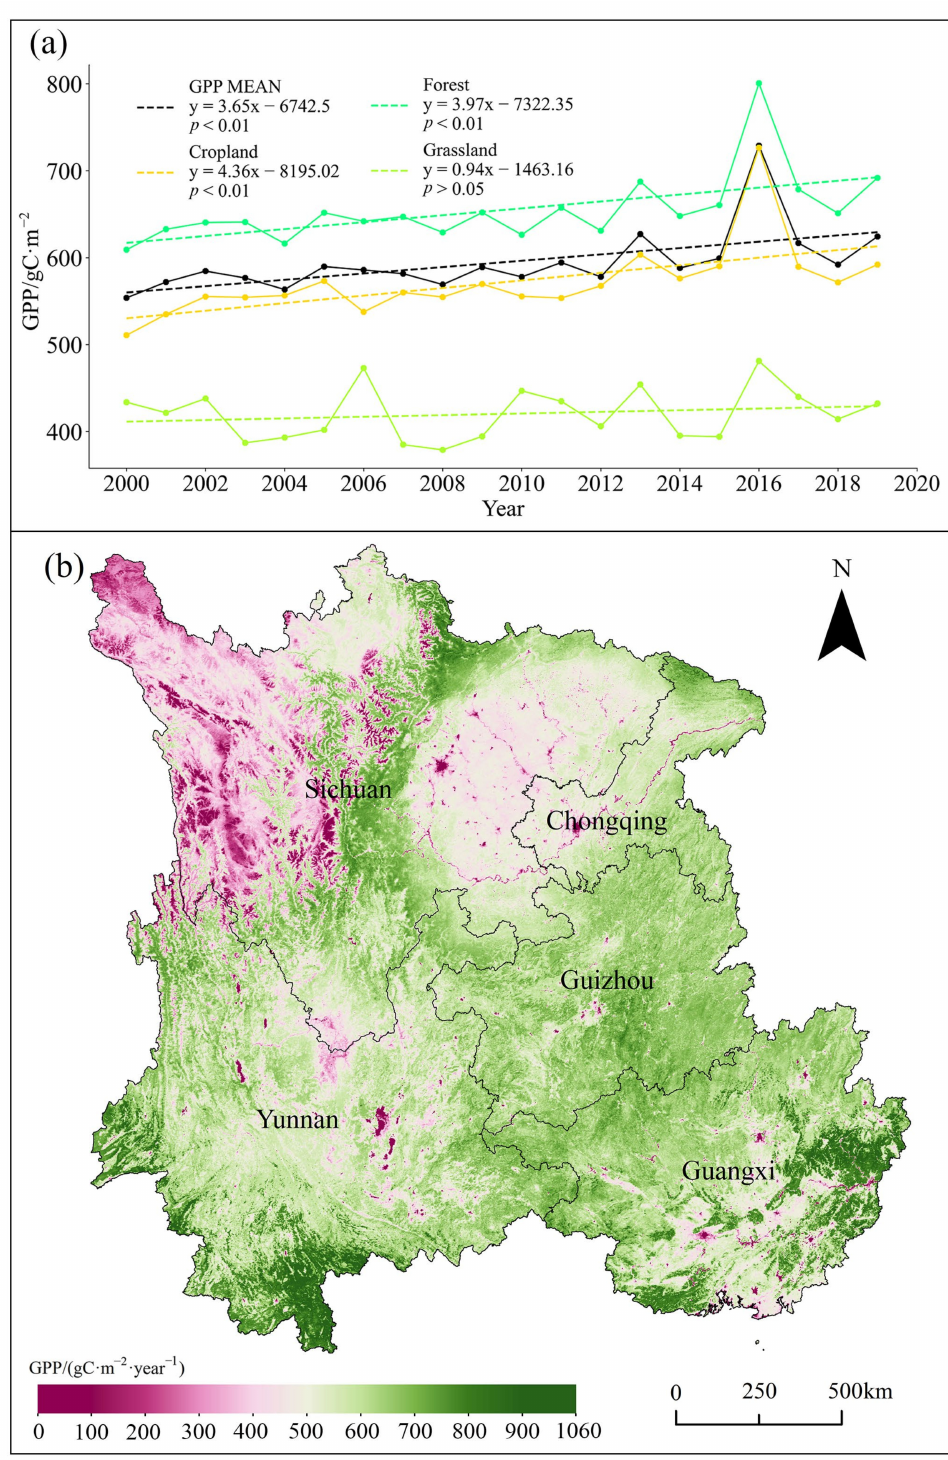
Figure 4. ( a ) Interannual GPP changes in different land use types; the dashed line shows the variation trend of GPP in different land use types, where the black is GPP mean, the formula is y = 3.65x − 6742.5; the yellow is cropland’s GPP, the formula is y = 4.36x − 8195.02; the cyan is forest’s GPP, the formula is y = 3.97x − 7322.35; the light green is grassland’s GPP, the formula is y = 0.94x − 1463.16 and ( b ) spatial distribution pattern of GPP values of different land cover types in Southwest China from 2000 to